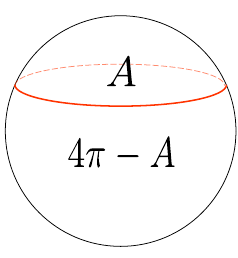
Figure 2 . The 1 = 8-BPS Wilson loop on S 2 . The 1 = 8-BPS loop can be de(cid:12)ned on an arbitrary contour on S 2 and its coupling to scalars is given by (2.1). A single loop divides S 2 into two regions, one with area A and the other with area 4 (cid:25) (cid:0) A . Its expectation value depends only on the area A owing to the relation to 2d